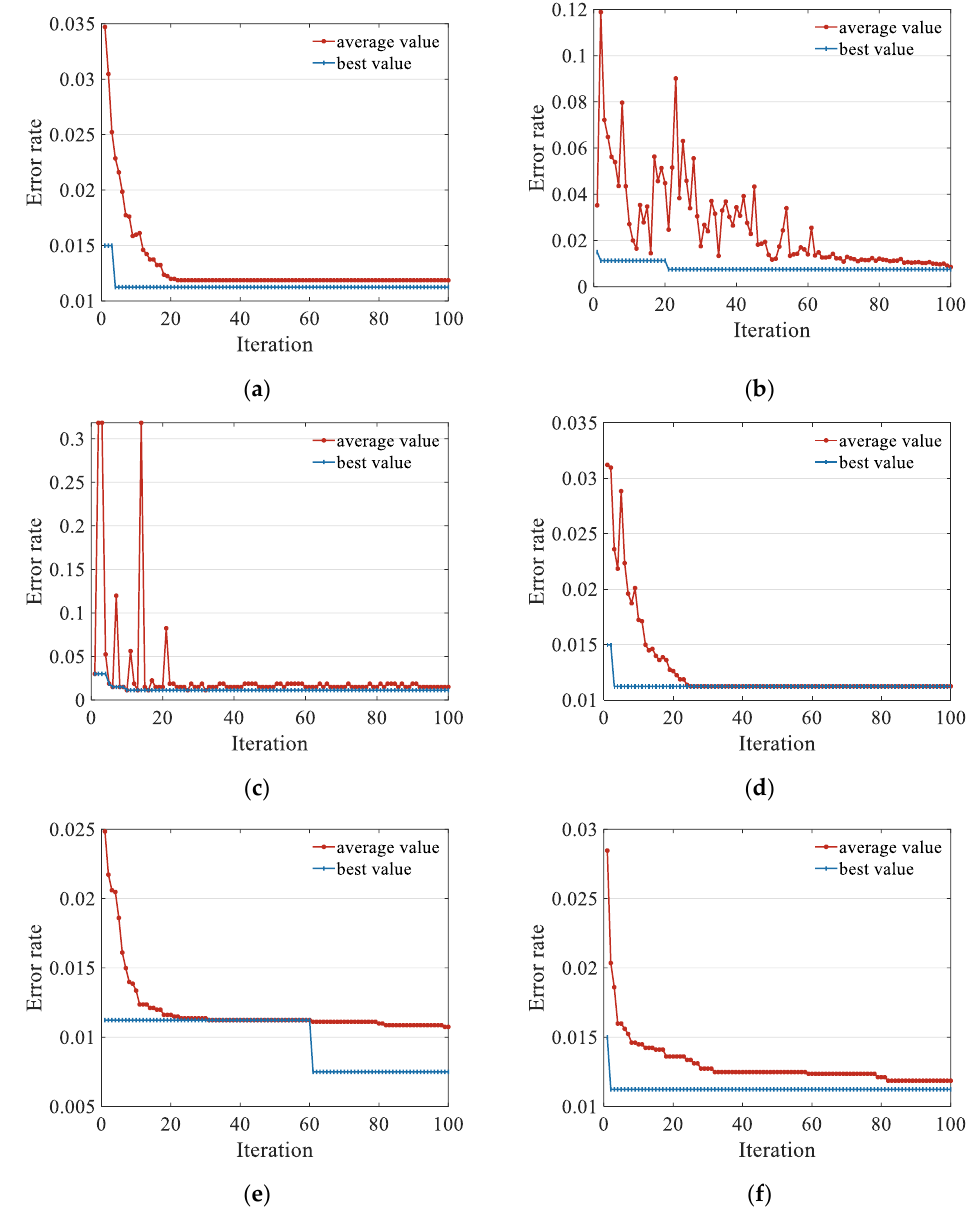
Figure 11. Comparison of evaluation indices: ( a ) GSA-SVM; ( b ) WOA-SVM; ( c ) GWO-SVM; ( d ) FA-SVM; ( e ) SSA-SVM; ( f ) FA-SSA-SVM.